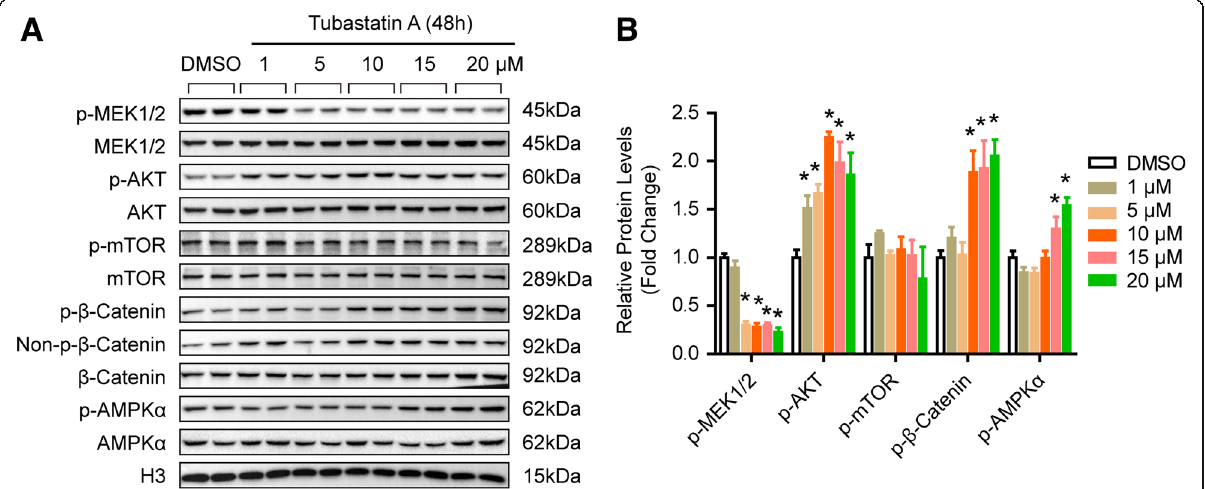
Fig. 6 The signaling pathways regulated by HDAC6. a and b Western blot was used to detect the signaling molecules in the primary cultured HAVSMCs treated with DMSO or different concentrations of tubastatin A ( n = 4 samples per group), * p < 0.05 vs.